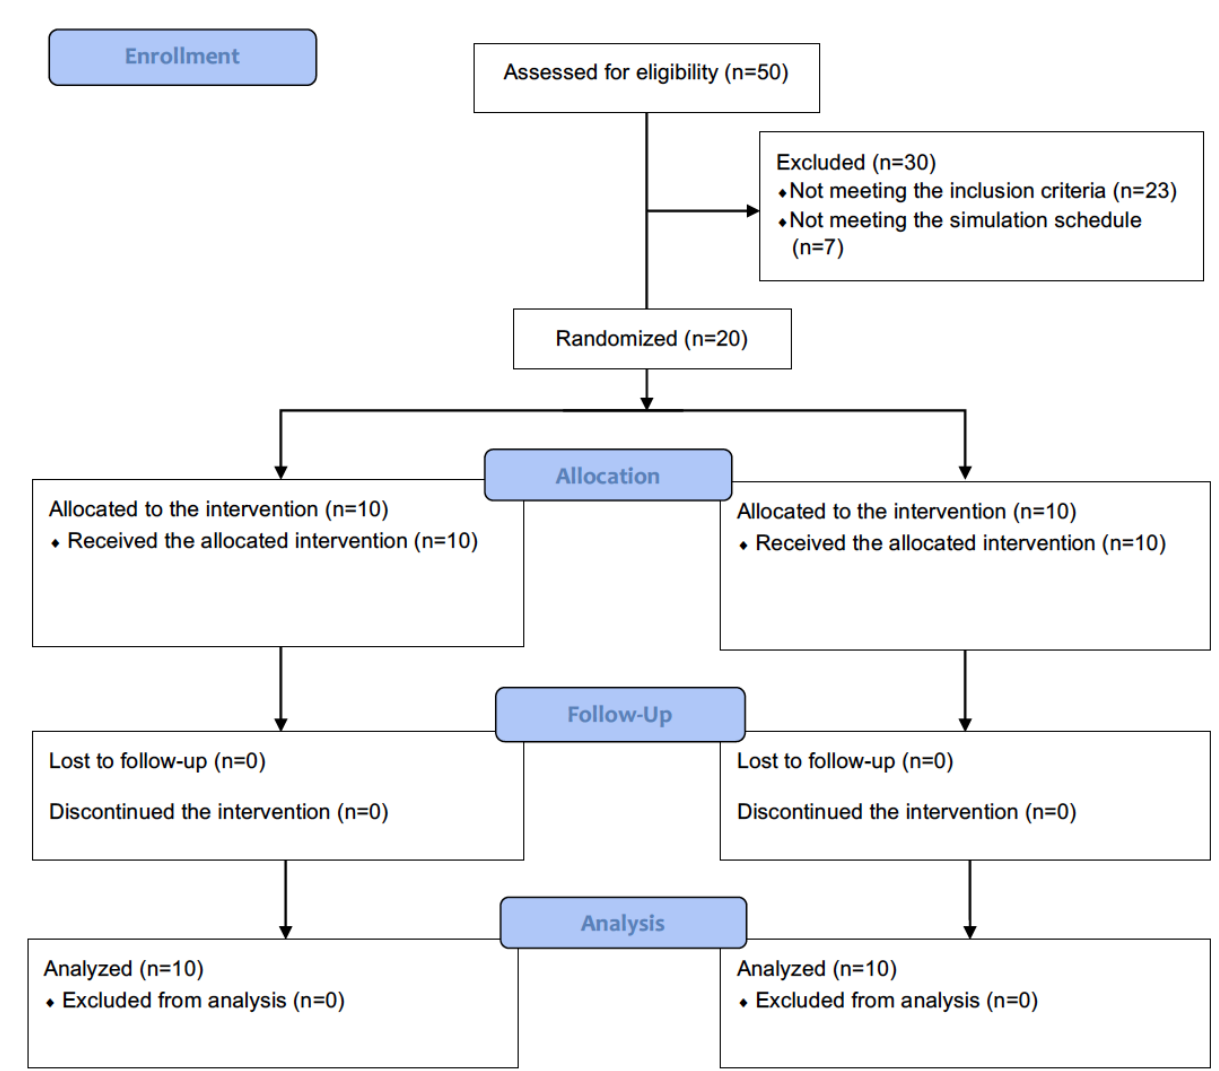
Figure 3. CONSORT disgram for the simulation